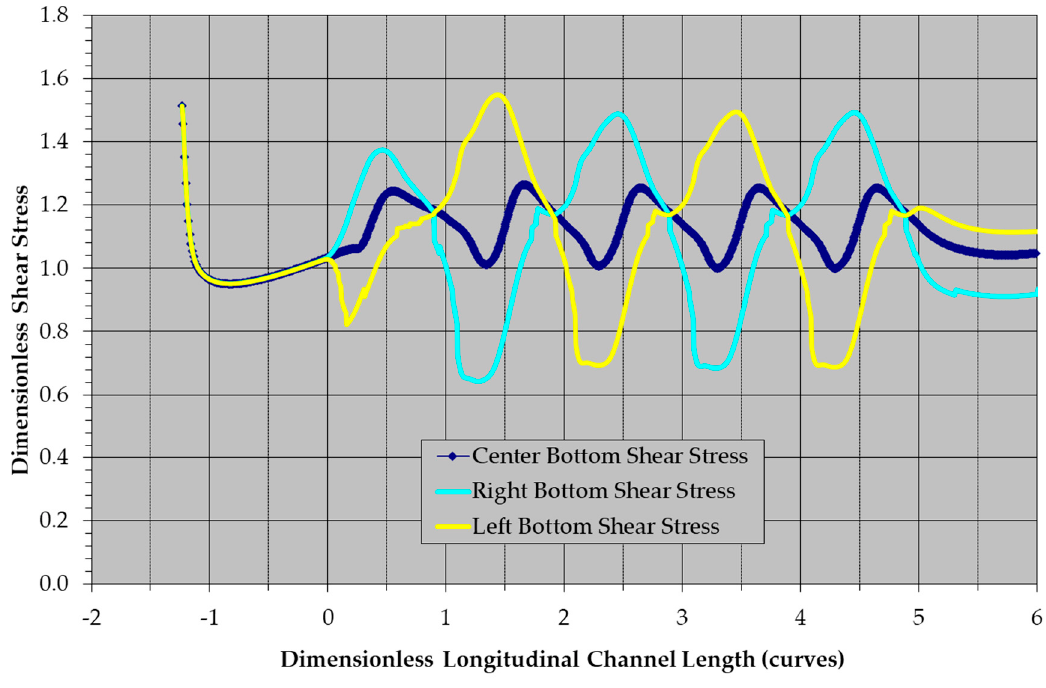
Figure 41. Dimensionless shear stress along the channel centerline, left and right banks for Simulation Set 7 with a sinuosity of 2.00 and a width/depth ratio of 7.3.